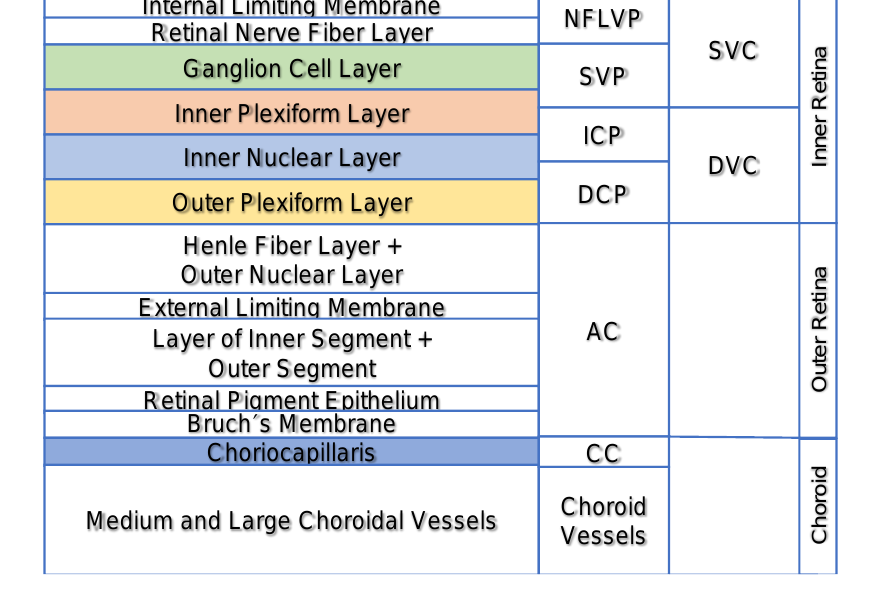
Figure 1. The relationship of the retina layers to the analyzed layers. ( Left ): Schematic of retinal layers from inside to outside. ( Right ): Schematic figure of the slab definitions of SPECTRALIS. Abbreviations in alphabetic order: AC: avascular complex; CC: choriocapillaris; DCP: deep capillary plexus; DVC: deep vascular complex; ICP: intermediate capillary plexus; NFLVP: nerve fiber layer vascular plexus; SVC: superficial vascular complex; SVP: superficial vascular plexus.